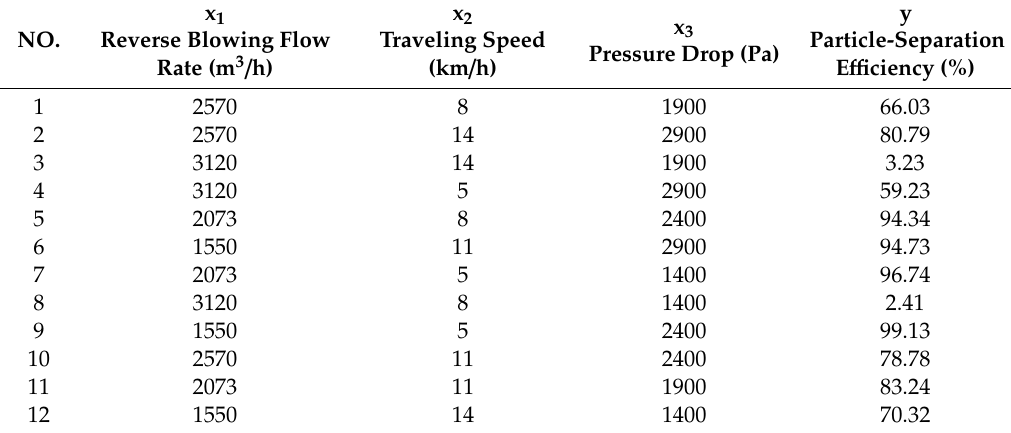
Table 3. Factor Level Table of Operational Parameters and Experimental Results.